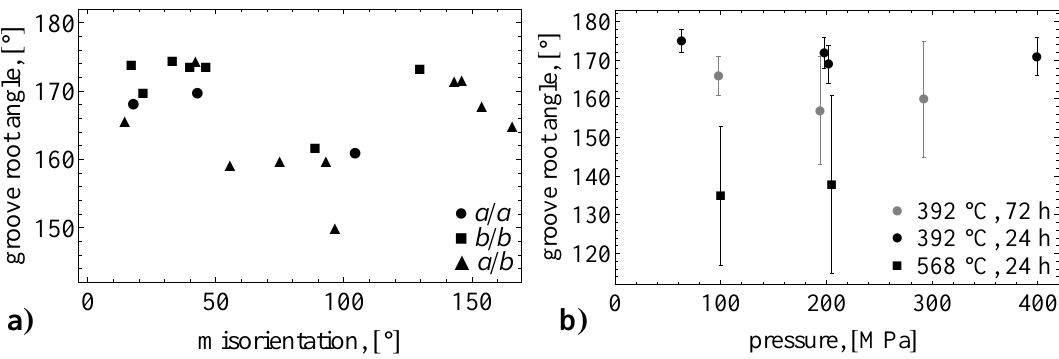
Figure 11. Relation between observed groove-root angle α (see Fig. 1) and (a) misorientation between neighboring grains with a axes or b axes normal to the sample surface and (b) pressure for indicated annealing time and temperature. Misorientation is quantified by the angle between the c axes of the neighboring grains. Error bars represent standard deviations (see Table 2).